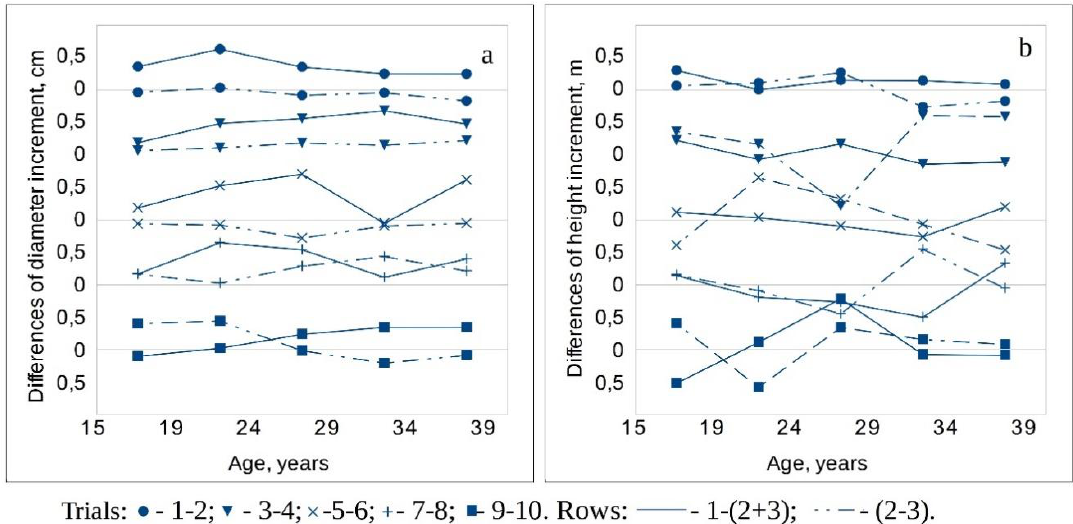
Figure 4. Changes of diameter ( a ) and height ( b ) periodical (4–5 years) increment differences between trees, growing in the 1 and 2 + 3 rows as well as between 2 and 3 rows depending on age and density of growing